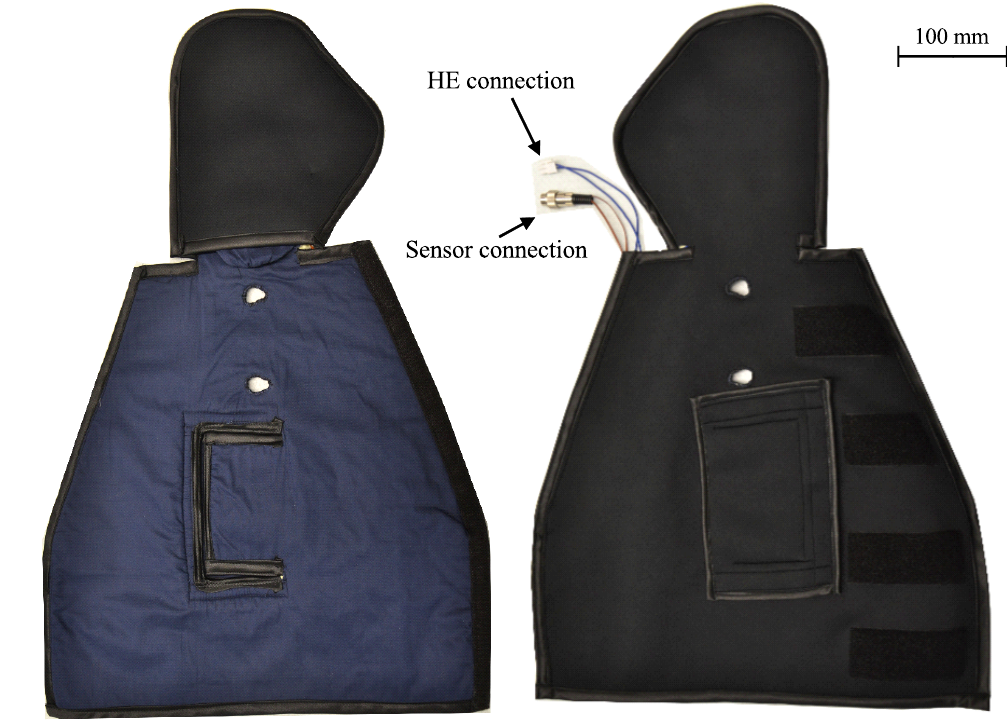
Figure 12. Prototype of the function integrative